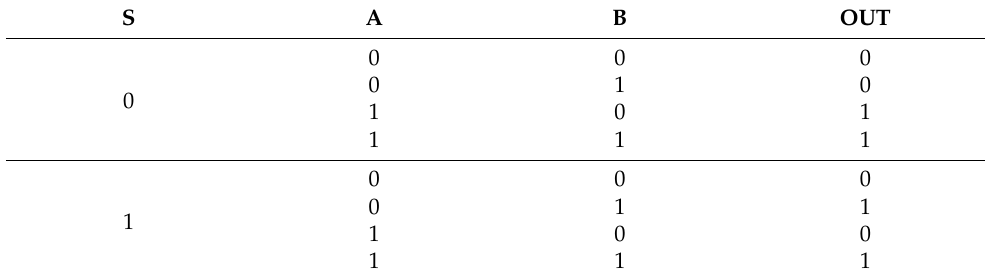
Table 2. Truth table of 2-to-1 Multiplexer.